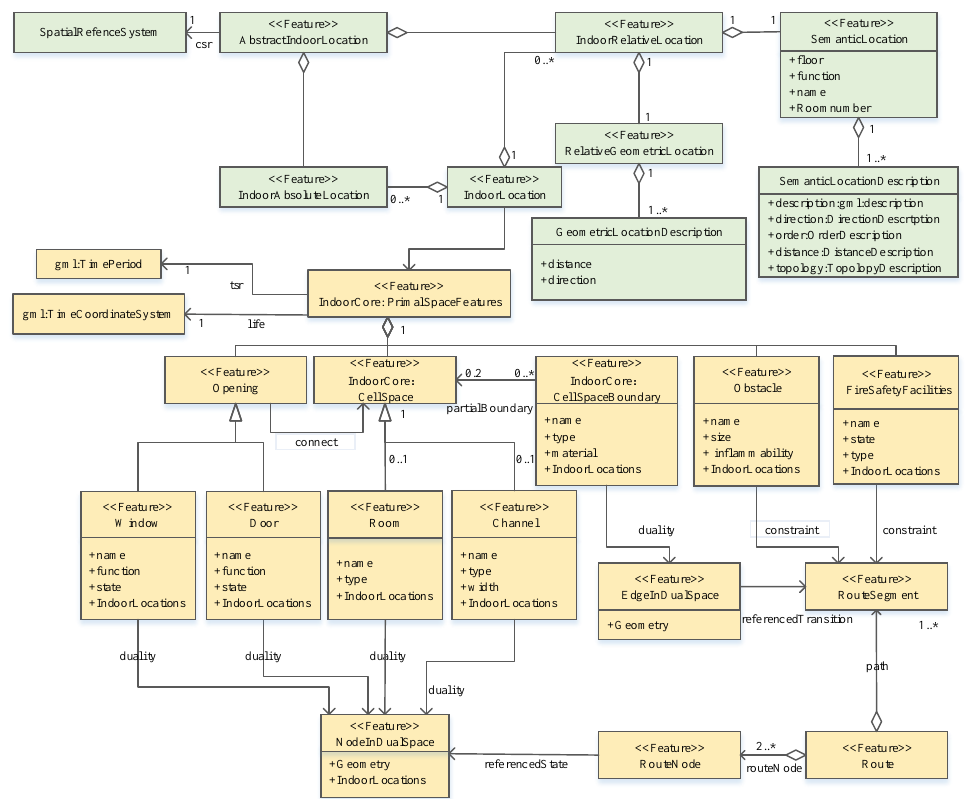
Figure 2. The Unified Modeling Language (UML) diagram of indoor model for fire evacuation.